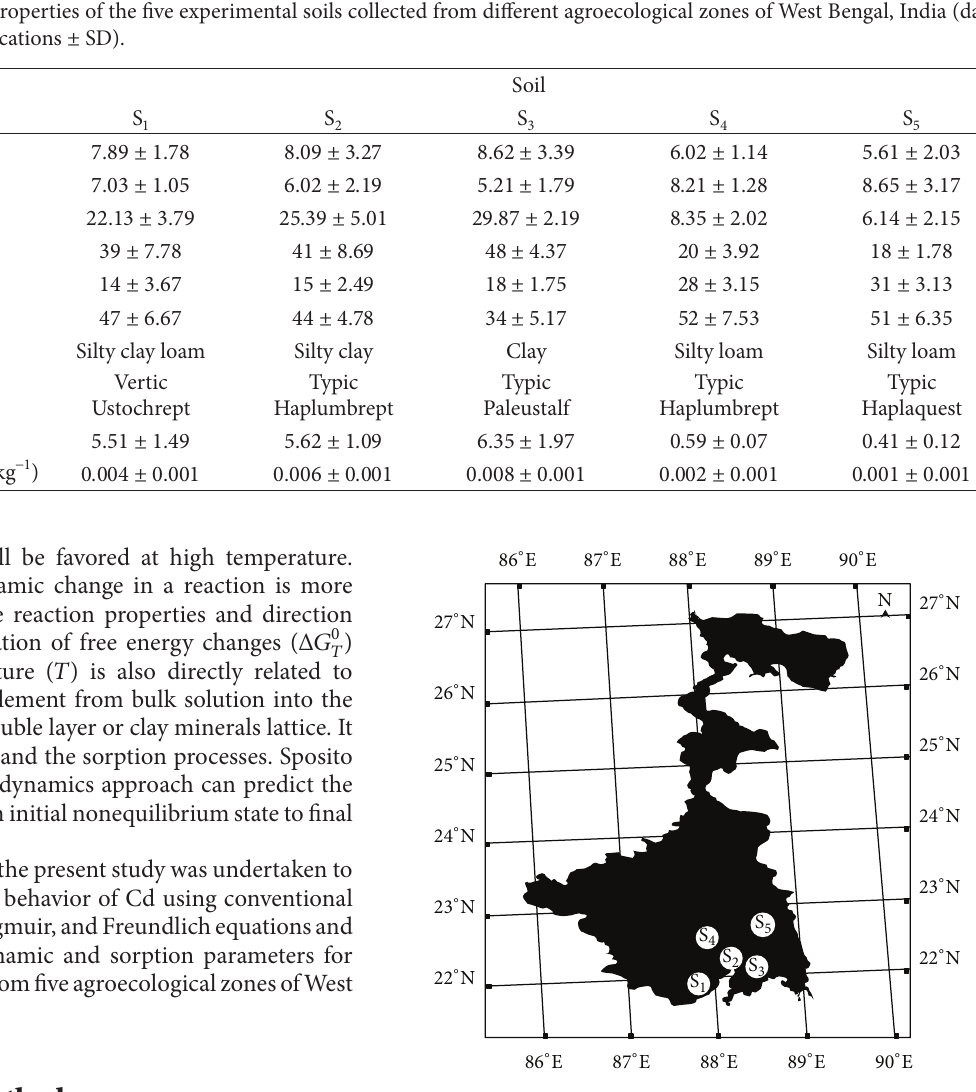
Figure 1: Location map (not in scale) of the sampling site. S 𝑛 stands for sampling location